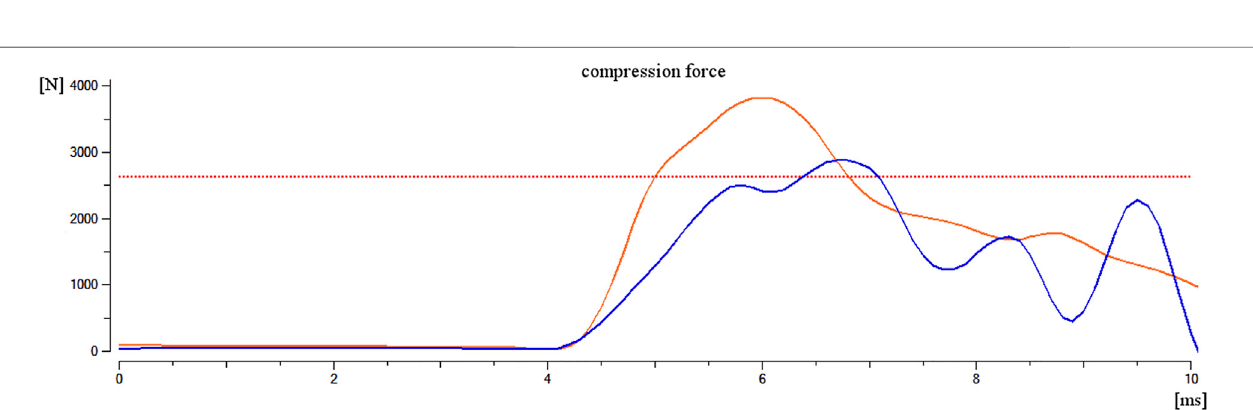
FIGURE5 | Comparison ofcompressive force in thelower tibia for theMil-LX model (orange line) with compressive forceinthe ankle for theanatomicallimb model (blue line); the red line indicates the 2.6-kN injury criterion.